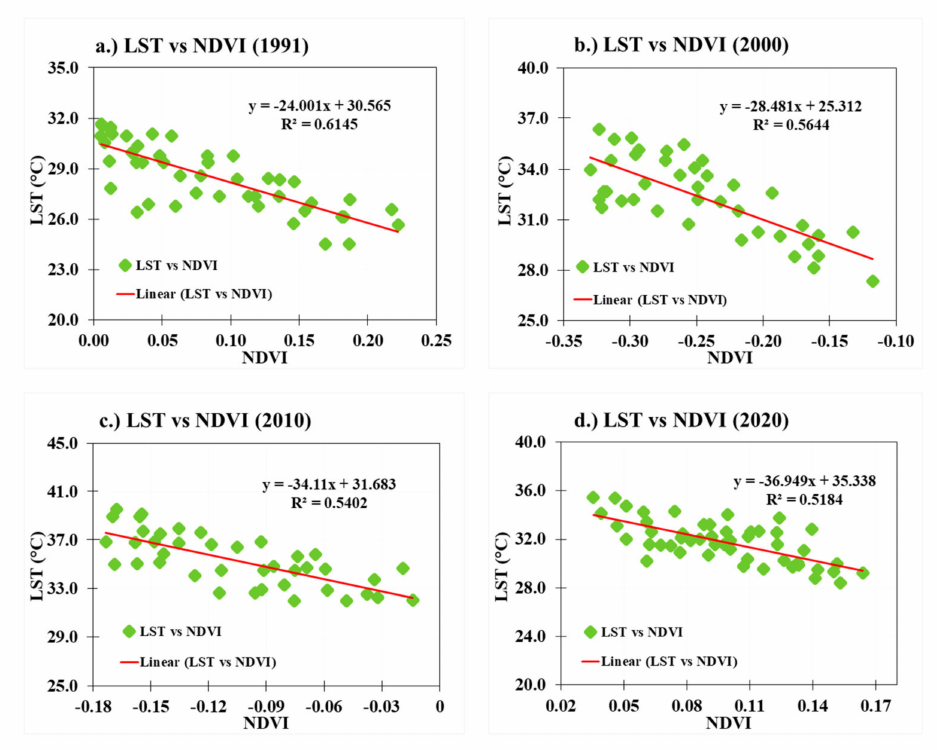
Figure 12. Correlation between LST and NDVI for the years ( a ) 1991, ( b ) 2000, ( c ) 2010, and ( d ) 2020.